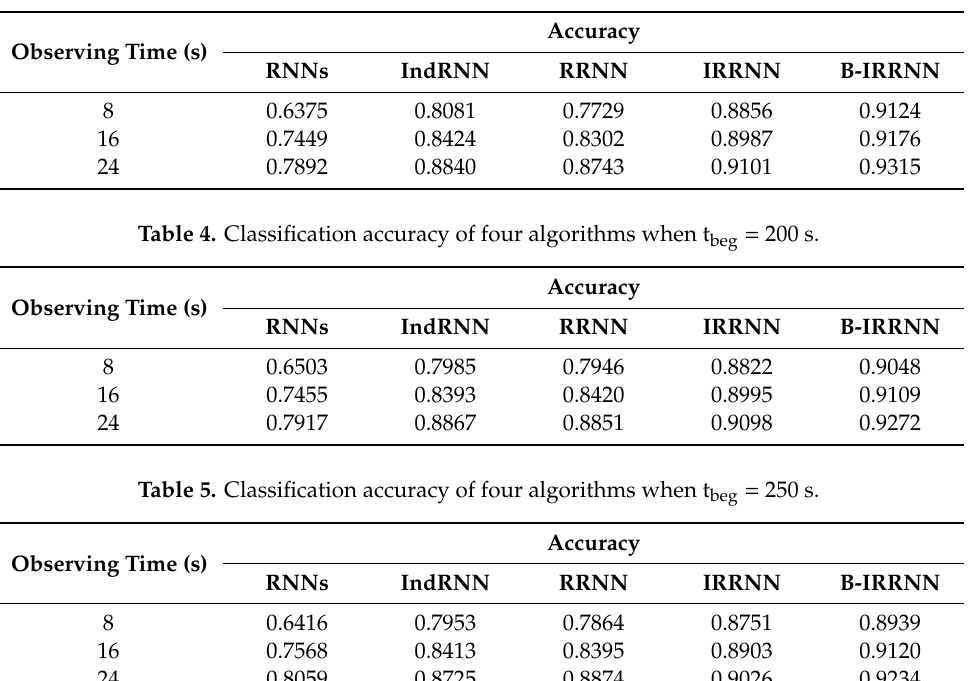
Table 3. Classification accuracy of four algorithms when t beg = 150 s.